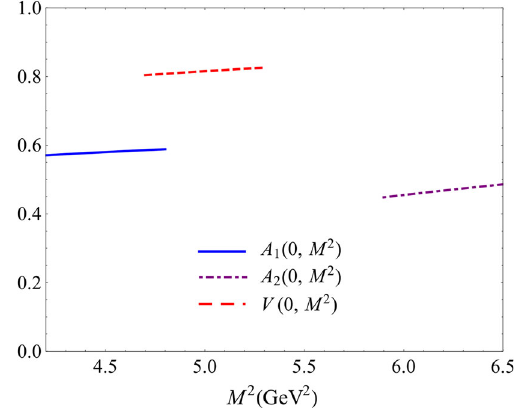
Fig. 5 The determined Borel windows for the TFFs at the large recoil point, A 1 , 2 ( 0 ) and V ( 0 )